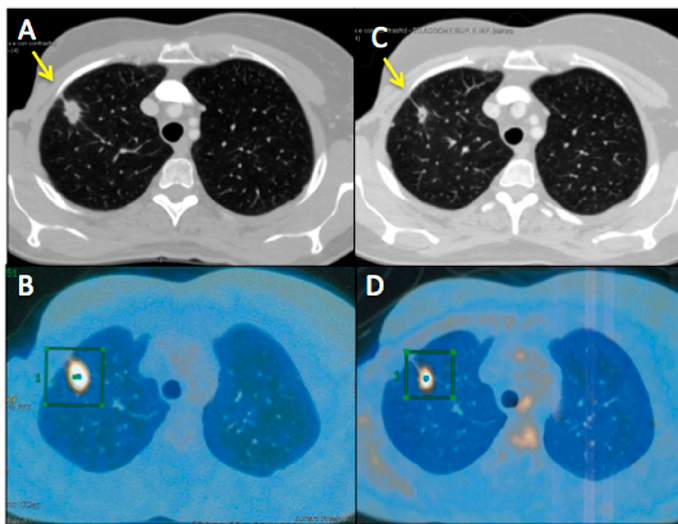
(maximum diameter: 44 mm, yellow arrows). According to mRECIST, patient was classified as SD. Ca19.9 and Carcino-Embryonic Antigen (CEA) values evaluated at baseline were 99 UI/mL and 65 ng/mL, respectively; while Ca19.9 and CEA values evaluated at timepoint-1 were 81 UI/mL and 60 ng/mL, respectively. Side effects reported were limited to nausea and mild position-related pain during HT sessions.